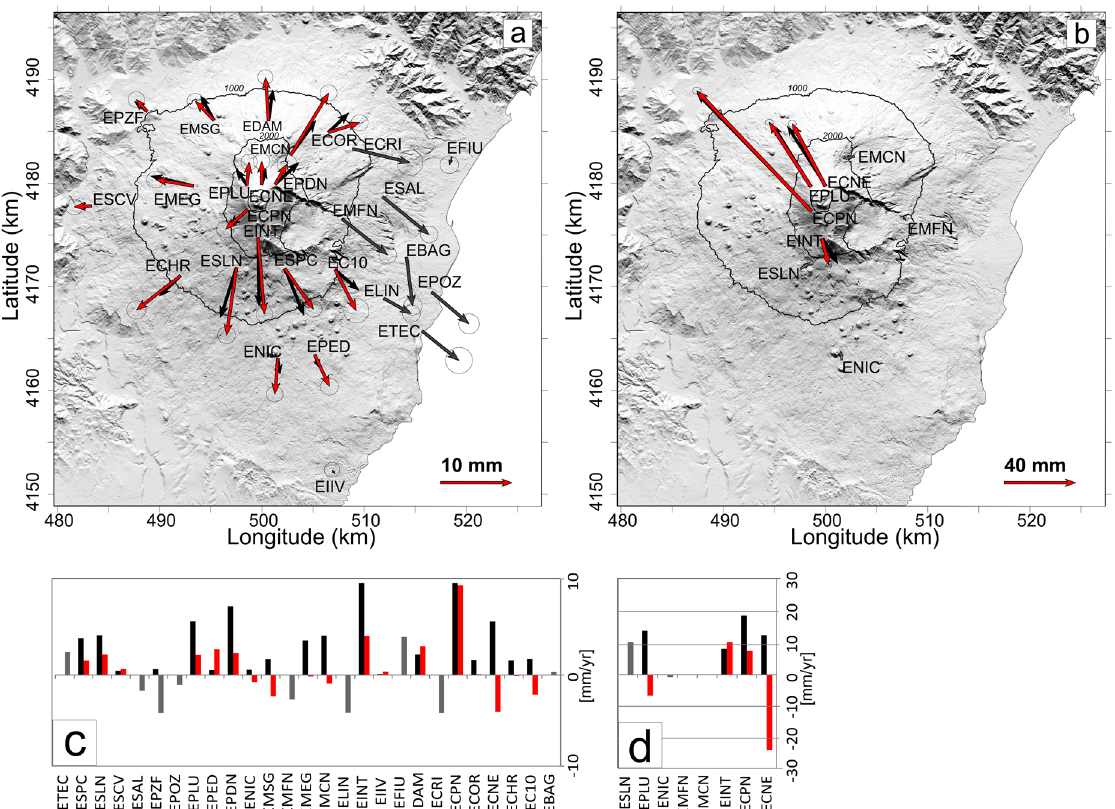
Figure 3. Recorded (red and grey arrows) and modelled (black arrows) horizontal CGPS displacements for the periods ( a ) 21 August - 25 December 2014, ( b ) 27–29 December 2014. Grey arrows were not considered in the modelling because the CGPS stations are on the eastern flank of Mt. Etna, characterized by a southeastward displacement not directly related to volcanic activity 61 ; ( c , d ) the histograms show the recorded (red bars) and modelled (black bars) vertical displacements for each of the two phases respectively. This figure was created using CorelDRAW ™ graphic suite software (http://www.corel.com/it/). The topography is based on a DEM held by INGV-OE, Cartography Lab